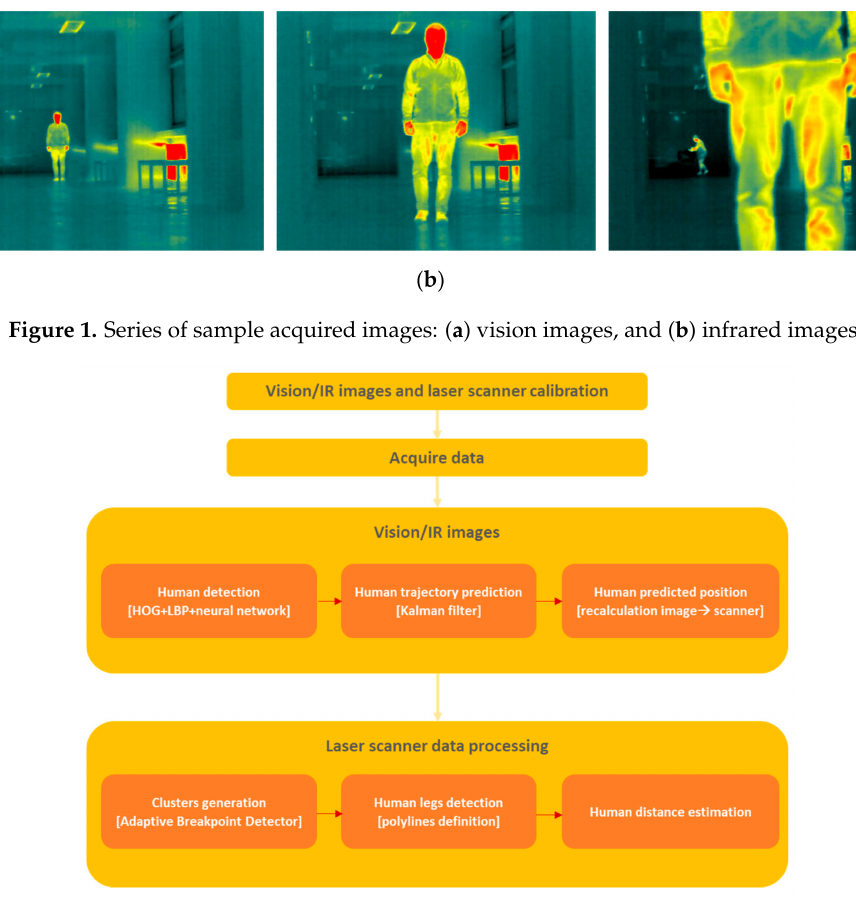
Figure 2. Block diagram of the proposed